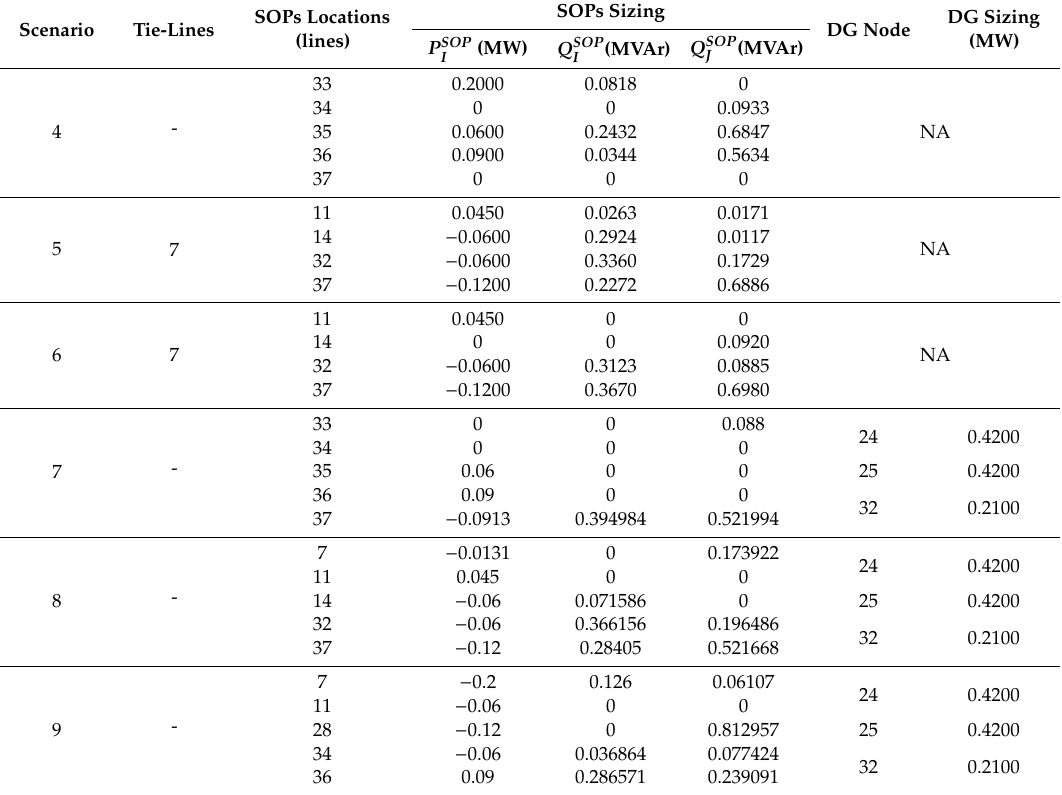
Table A1. Optimal system configuration, sizing, and locations of SOPs and DGs for scenarios 4 to 9 without SOPs internal losses at normal loading level: IEEE 33-node distribution system.